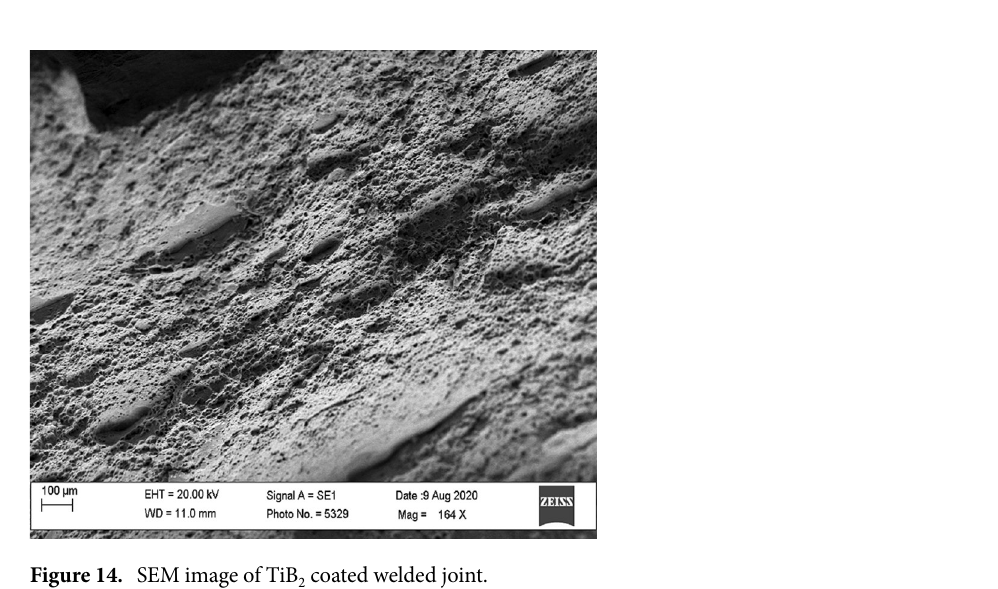
Figure 14. SEM image of TiB 2 coated welded